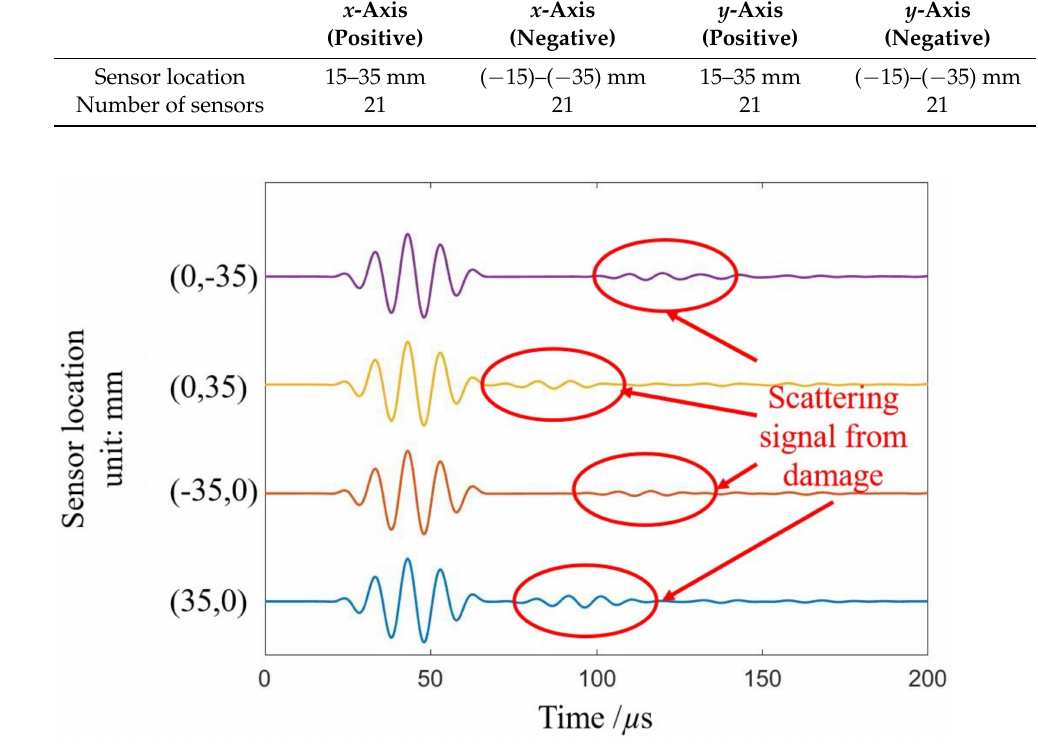
Figure 5. Typical received signals, including the incident and reflected